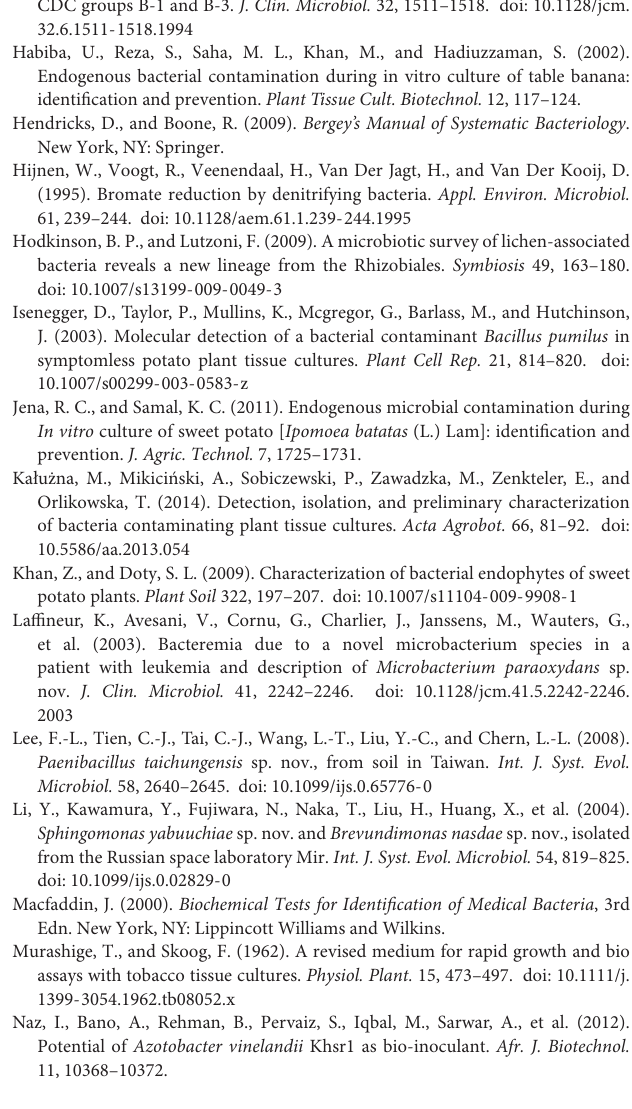
TABLE S3 | Reported habitat and benefits of bacteria related to those identified in this